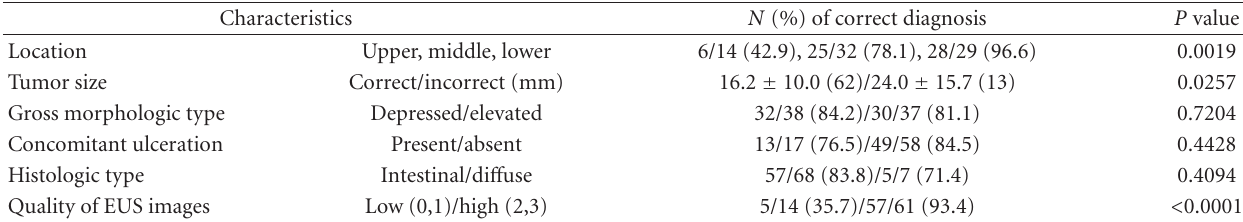
Table 3: Univariate analysis of clinicopathologic factors for diagnostic accuracy of